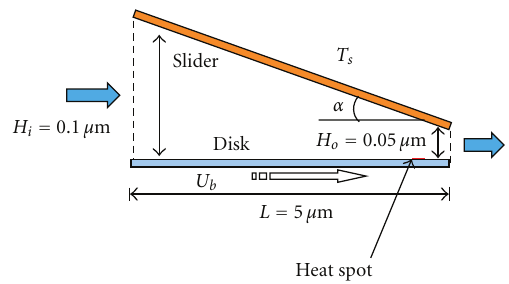
Figure 1: The slider and disk layout in the bearing interface.